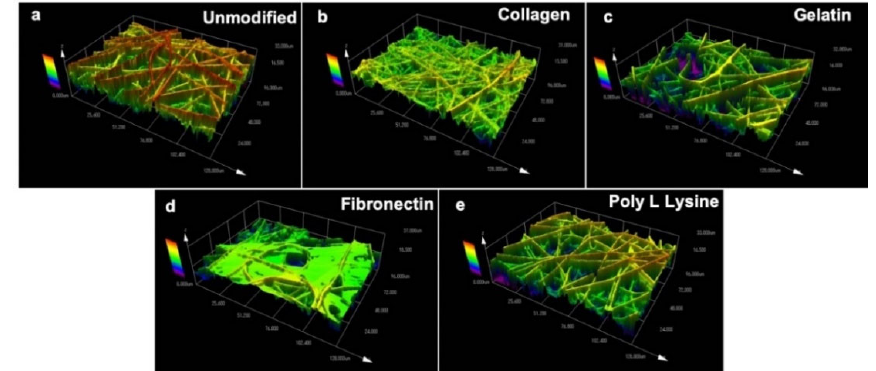
Figure 3. Surface topography of ( a ) unmodified PLLA scaffold and ECM protein surface functionalized PLLA scaffolds ( b ) Collagen, ( c ) Gelatin ( d ) Fibronectin ( e ) Poly L Lysine. The collagen, gelatin and fibronectin functionalized protein scaffold has masked the fiber with a thin film like protein sheet. The topography of collagen, gelatin, fibronectin sca ff olds have significantly changed in contrast to the surface topography of poly L lysine and unmodified sca ff